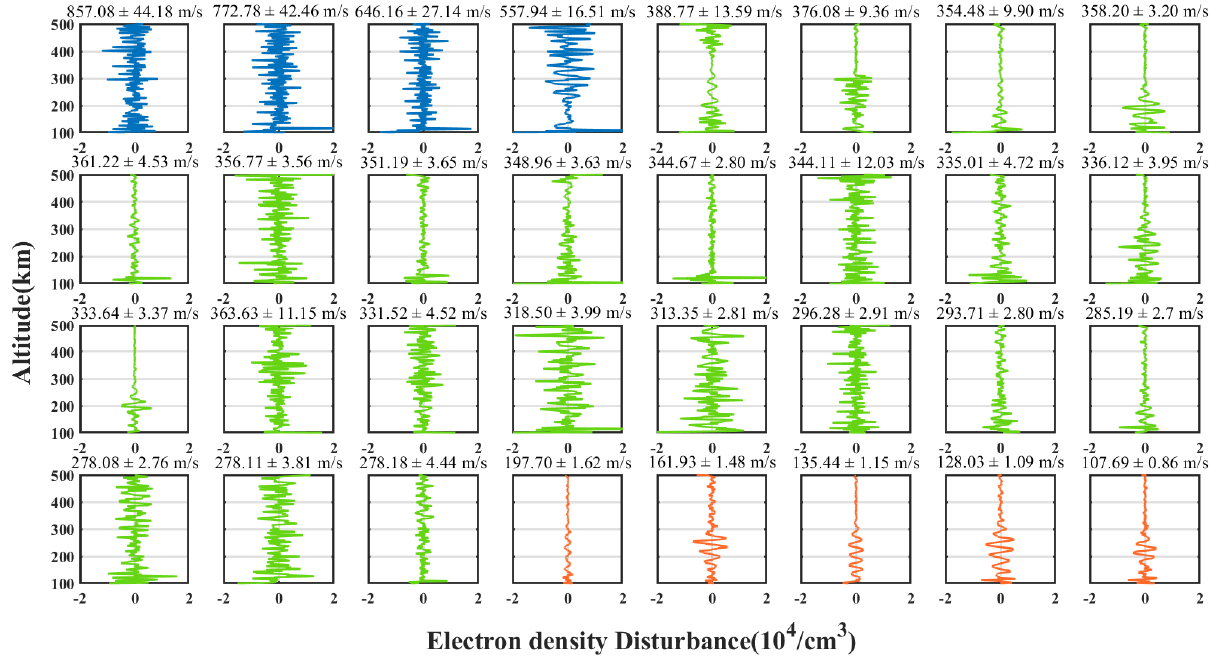
Figure 8. 32 The electron density disturbance on 15 January (acoustic-gravity wave disturbance: Prof#1–Prof#4; Lamb wave disturbance: Prof#5–Prof#27; tsunami wave disturbance: Prof#28– Prof#32)